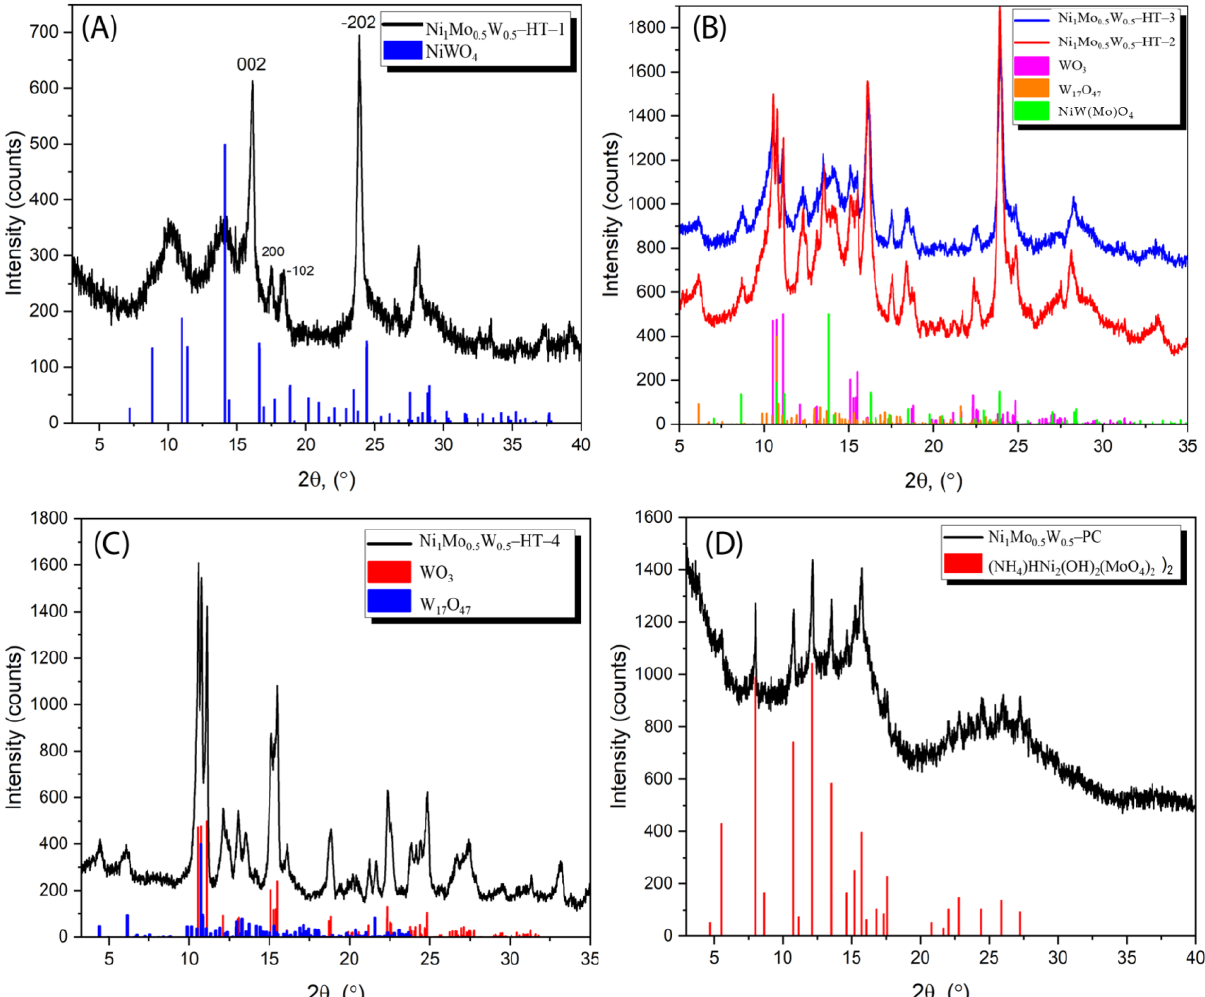
The X-ray diffraction (XRD) pattern of the Ni 1 Mo 0.5 W 0.5 –HT–1 catalyst is given in Figure 4A. The spectrum contains wide diffuse maxima and narrow peaks. The peaks observed at 16.13, 17.53, 18.38, 23.93 and 28.15 ◦ by 2 θ can be assigned to the nickel tungstate phase (NiWO 4 ; PDF# 00-015-0755) [6] or to the isostructural phase of nickel molybdate (NiMoO 4 ; PDF# 00-016-0291) [25]. It is also possible that the phase contains both tungsten and molybdenum atoms in the form of NiW(Mo)O 4 . However, the experimental diffraction pattern is characterized by strong broadening of the most intensive reflection ( − 111), as well as reflections (010) and (011), which are characteristic of such crystal phases. Similar diffraction patterns were recorded in studies in which the synthesis of nickel tungstate (NiWO 4 ) by the hydrothermal procedure [26,27] and the precipitation technique [28] was followed by drying at a low temperature. The observed features in the X-ray diffraction pat- terns can be explained by a poor NiWO 4 phase crystallization degree. The well-crystallized phase of nickel tungstate (NiWO 4 ) was formed after calcination at a higher temperature of 600 ◦ C [27,28]. These data strongly support the XRD data.